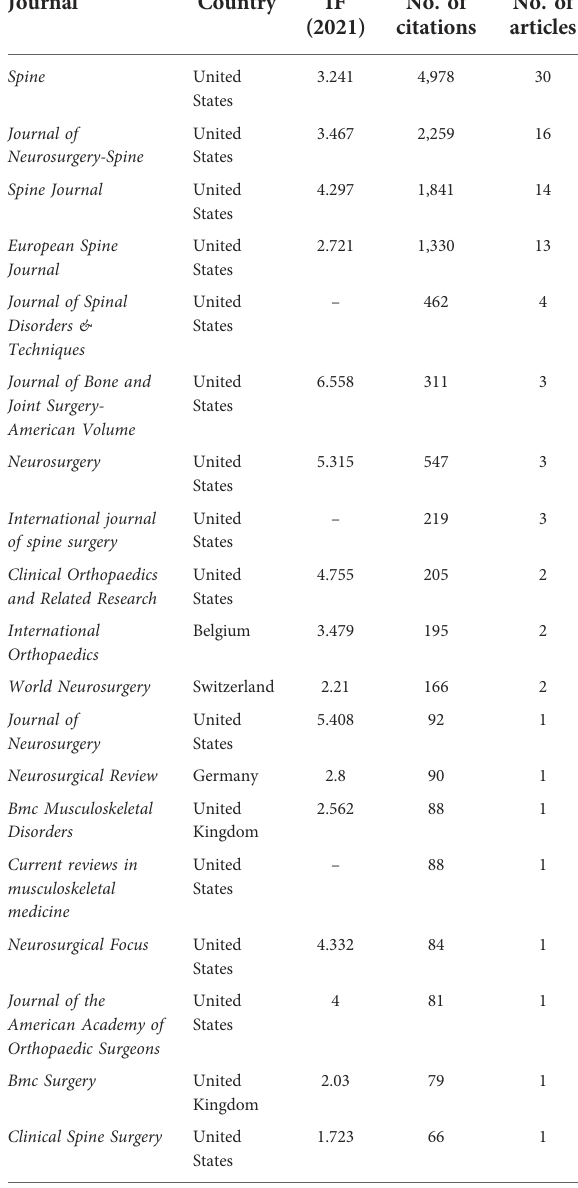
TABLE 3 Journals in which the top 100 cited articles were